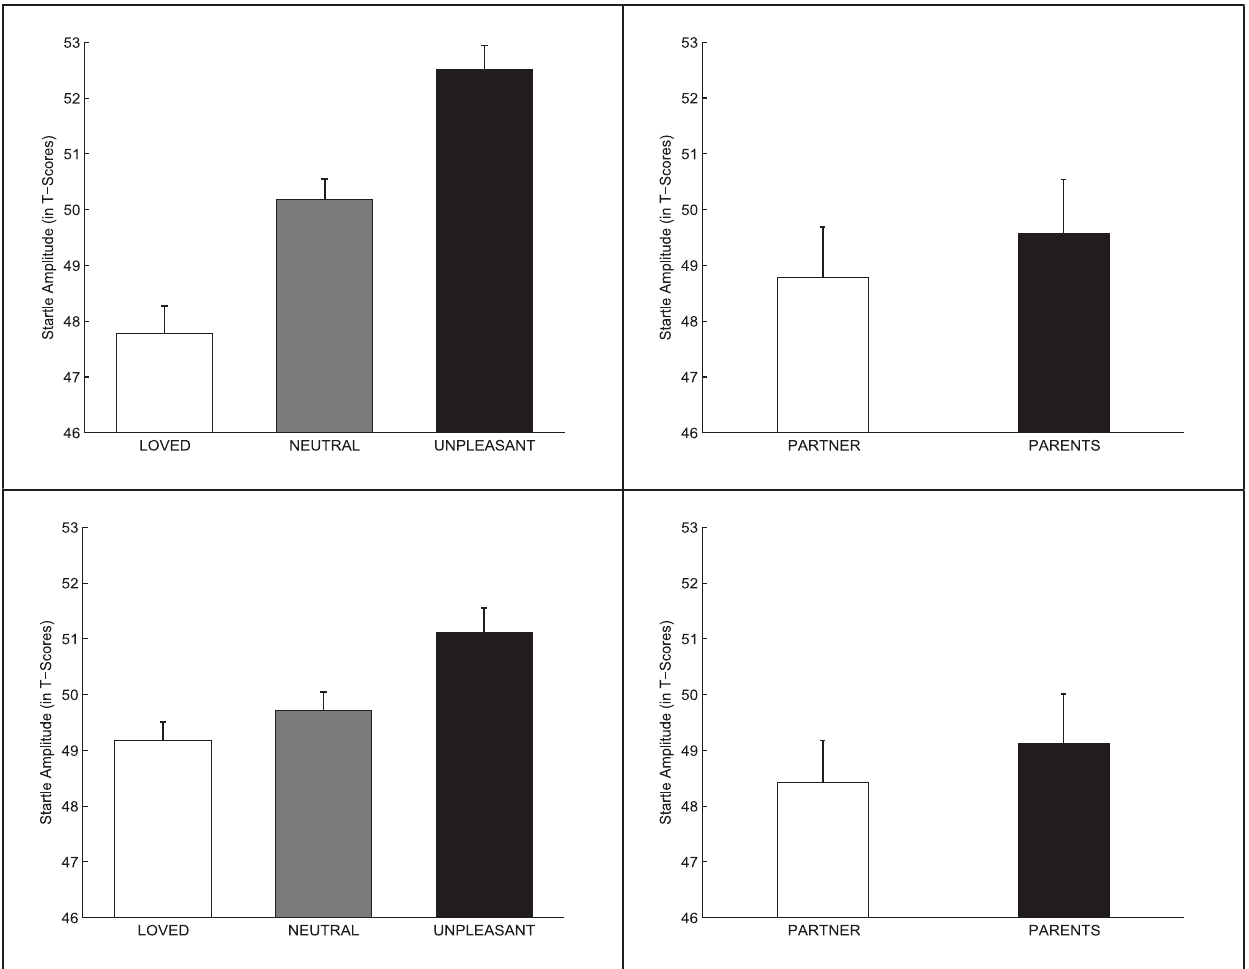
Figure 1. Startle reflex response to the faces. Magnitude of the startle reflex to the acoustic noise while participants viewed faces. Left: Loved vs. neutral vs. unpleasant faces (top: females; bottom: males). Right: Romantic partner (boyfriend/girlfriend) vs. same-sex parent (father/mother) faces (top: females; bottom: males). Bars are standard errors.